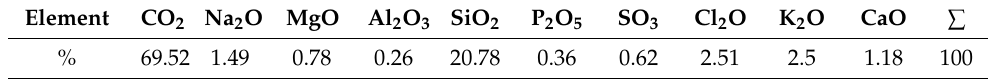
Table 4. Elemental composition of the original rice